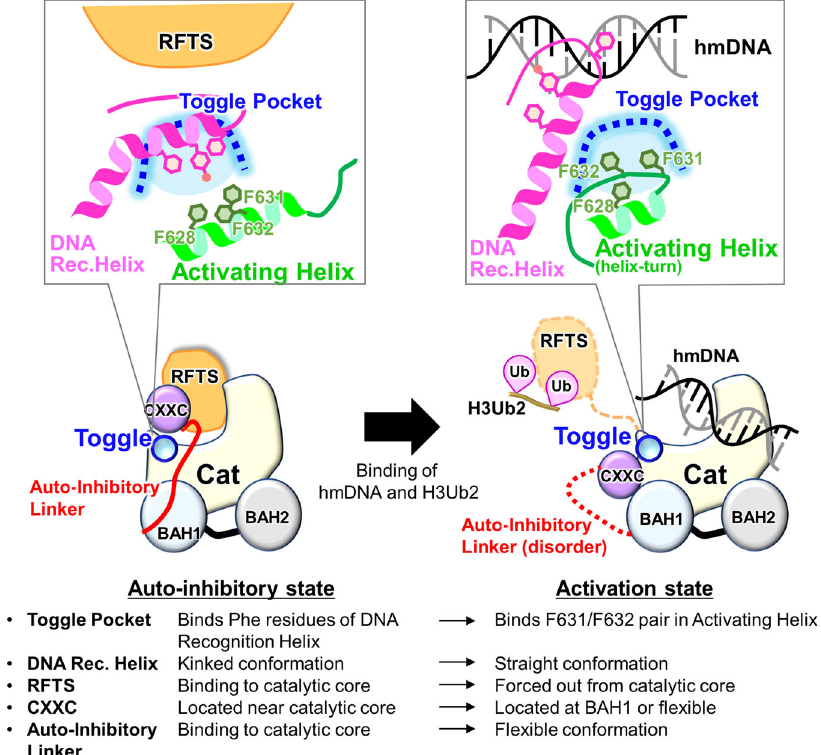
Fig. 5 | Schematic representation of the DNMT1 activation mechanism. Left and right fi gures show the auto-inhibitory and activation states of DNMT1,